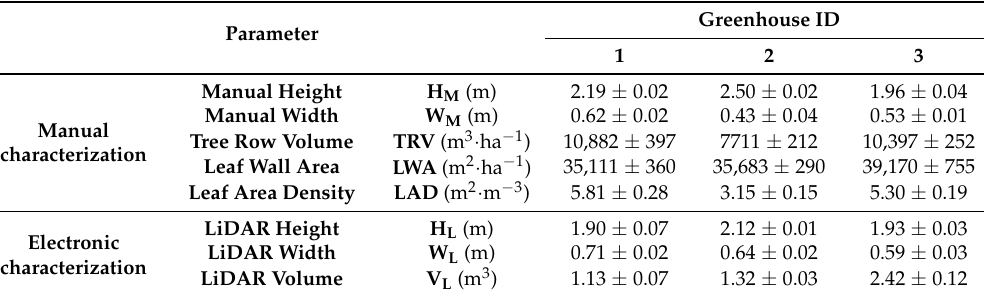
Table 2. Average measured and calculated geometrical and density parameters and its Standard Deviation of the